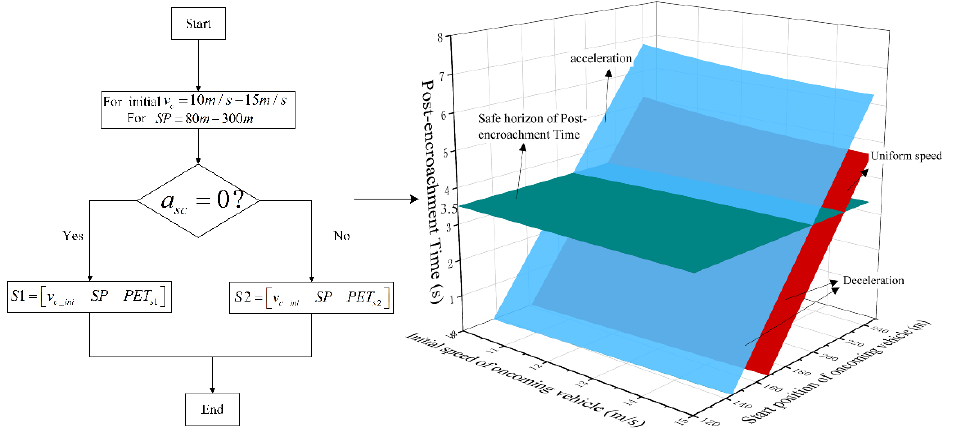
Figure 6. Calculation flow of post-encroachment time